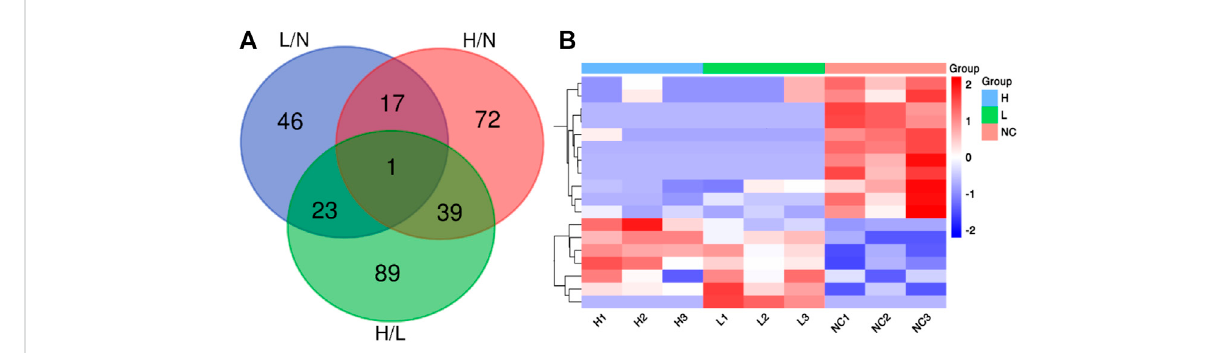
FIGURE 2 (A) VenndiagramshowingtheoverlapofDEPsinthecomparisonofseverePE/controlgroups,mildPE/controlgroupandseverePE/mildPE; (B) Heatmap analysis of 18 DEPs both in the comparison of severe PE/control group and mild PE/control group. L, mild PE; H, severe PE; N, control group.